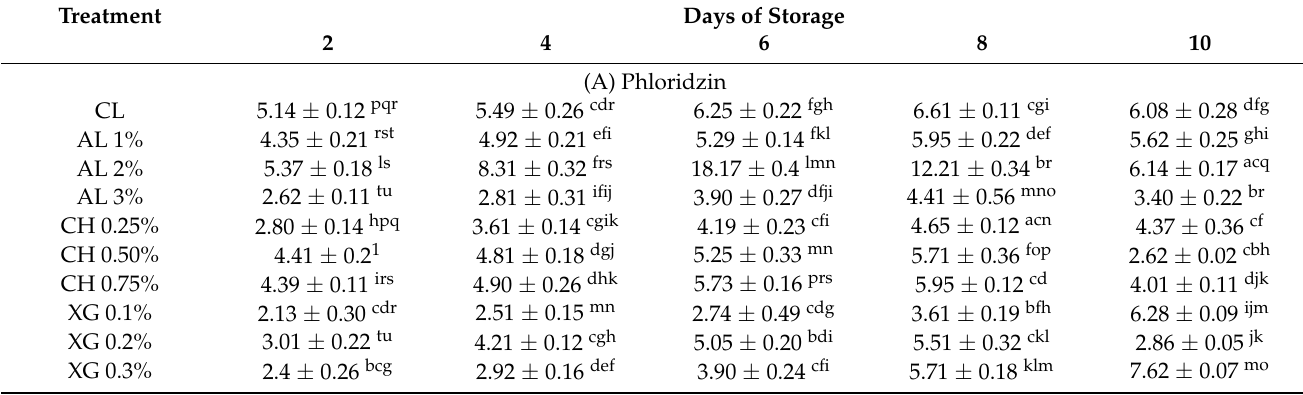
Table 4. Effects of polysaccharide-based coatings and storage on phloridzin, kaempferol, Quercetin-3-glucoside and procyanidin b 2 levels (mg/Kg